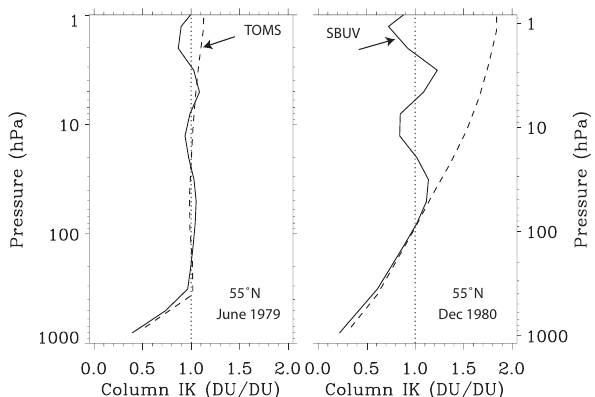
Fig. 10. Comparison of Nimbus-7 SBUV and TOMS integrating kernels (IKs) for ozone column. Column IK provides the fraction of O 3 change in a layer that would appear in the total O 3 column of the retrieved profile. A value of 1 represents ideal sensitivity. Though TOMS uses longer wavelengths than SBUV they both have similar IKs in the summer months when SZA is small. But at larger SZAs (55 ◦ N in December) TOMS become over-sensitive to O 3 variations at higher altitudes, causing increased noise in retrieved total O 3 . Since the TOMS algorithm uses climatological profiles to estimate total O 3 , this also causes biases when the true profile deviates from